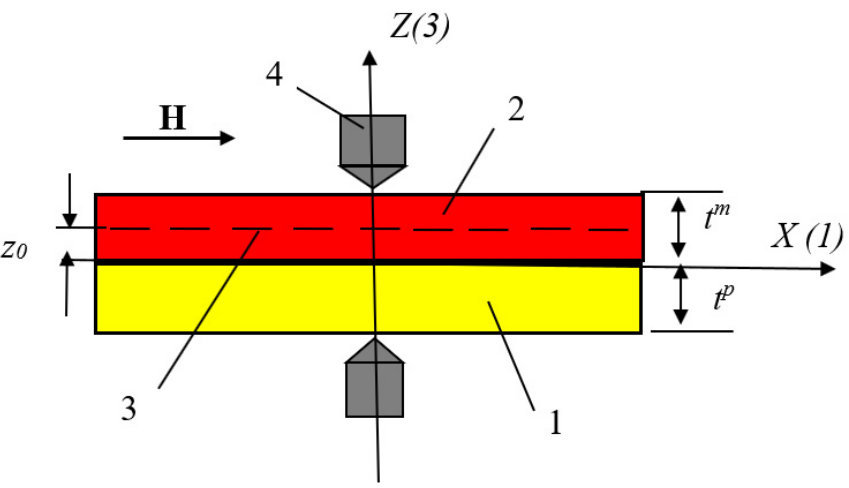
Figure 1. Schematic drawing of a magnetostrictive–piezoelectric bilayer showing the piezoelectric layer (1), magnetostrictive layer (2), neutral plane (3), and electrodes (4) .